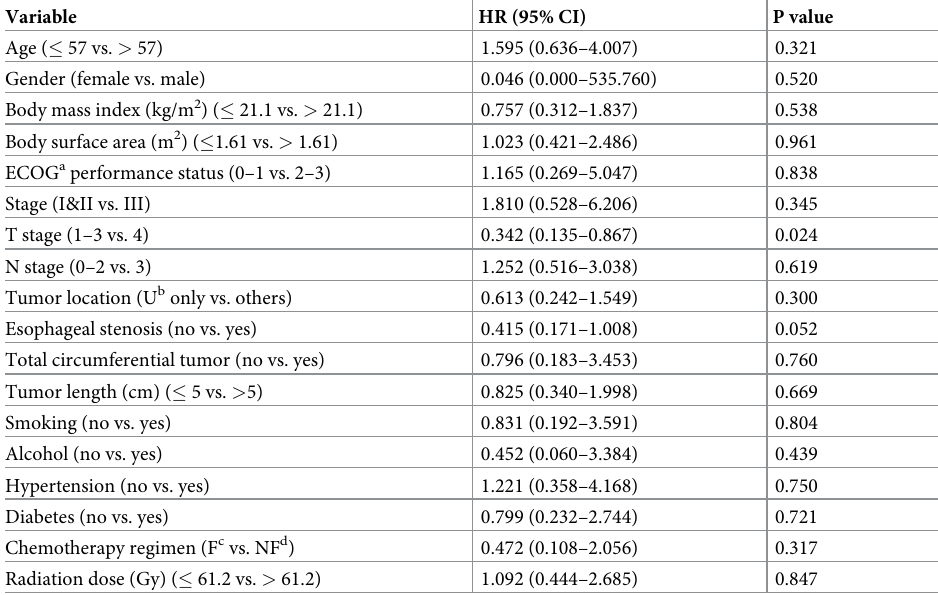
Table 2. Univariate analysis of clinical variables associated with esophageal fistula.